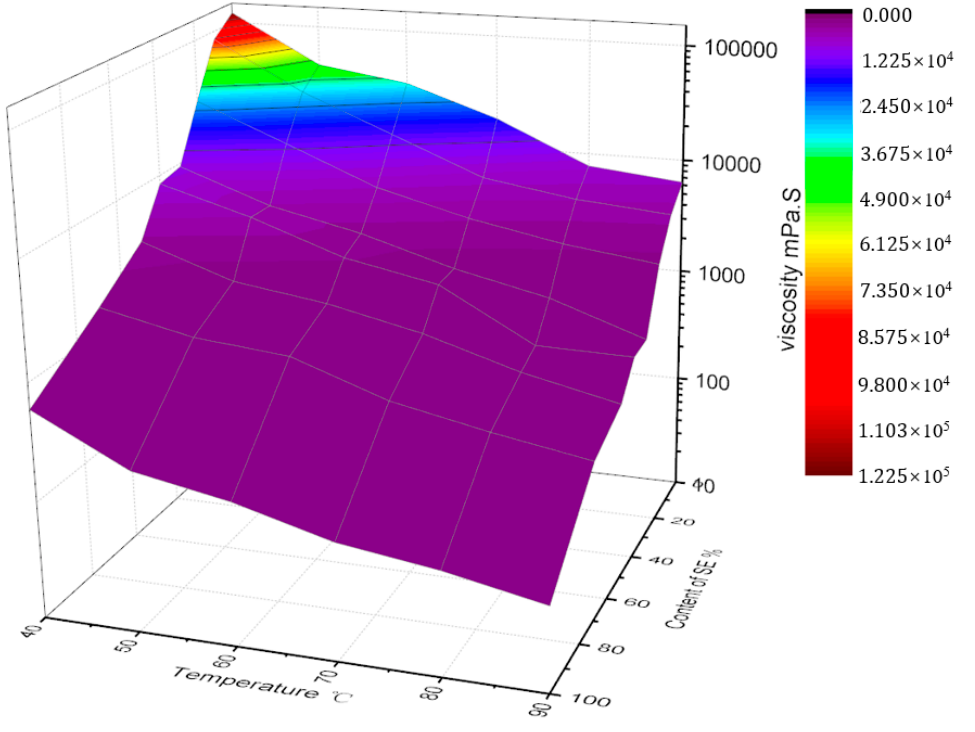
Figure 2. Viscosity distribution of HYW and SE mixed in different proportions at different temperatures. Table 5. Viscosity distribution of HYW and SE mixed in different proportions at different temperatures. Content of SE Emulsion